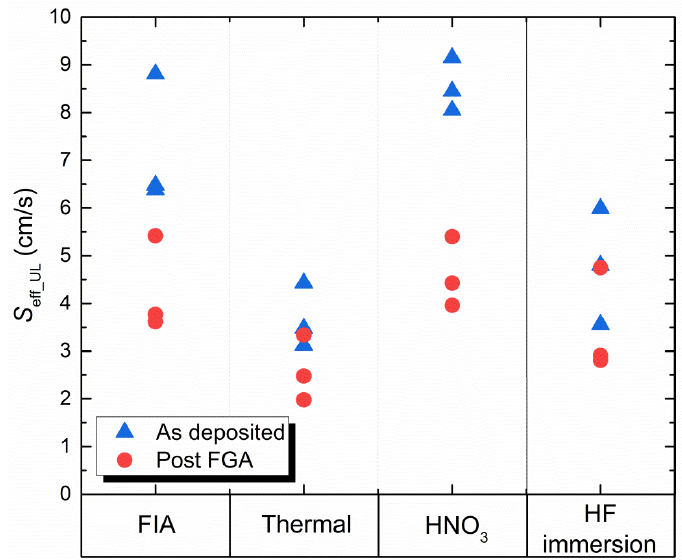
Figure 6. Values of S eff_UL extracted at ∆ n = 1 × 10 15 cm − 3 for n -Si samples passivated with ultra-thin SiO x formed by FIA, thermal oxidation and wet-chemical HNO 3 oxidation followed by a SiN x capping. Data presented includes three samples per oxidation condition. The values of S eff_UL for samples passivated by a single layer SiN x after HF immersion are also shown.